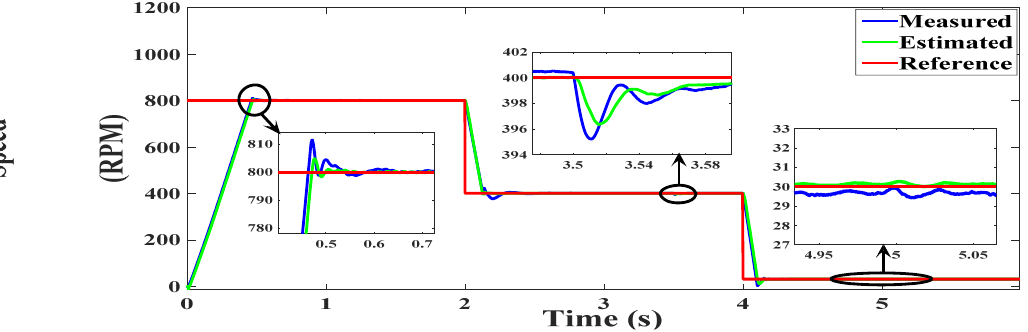
Figure 14. Rotor speed profile under proposed PVC approach (RPM).